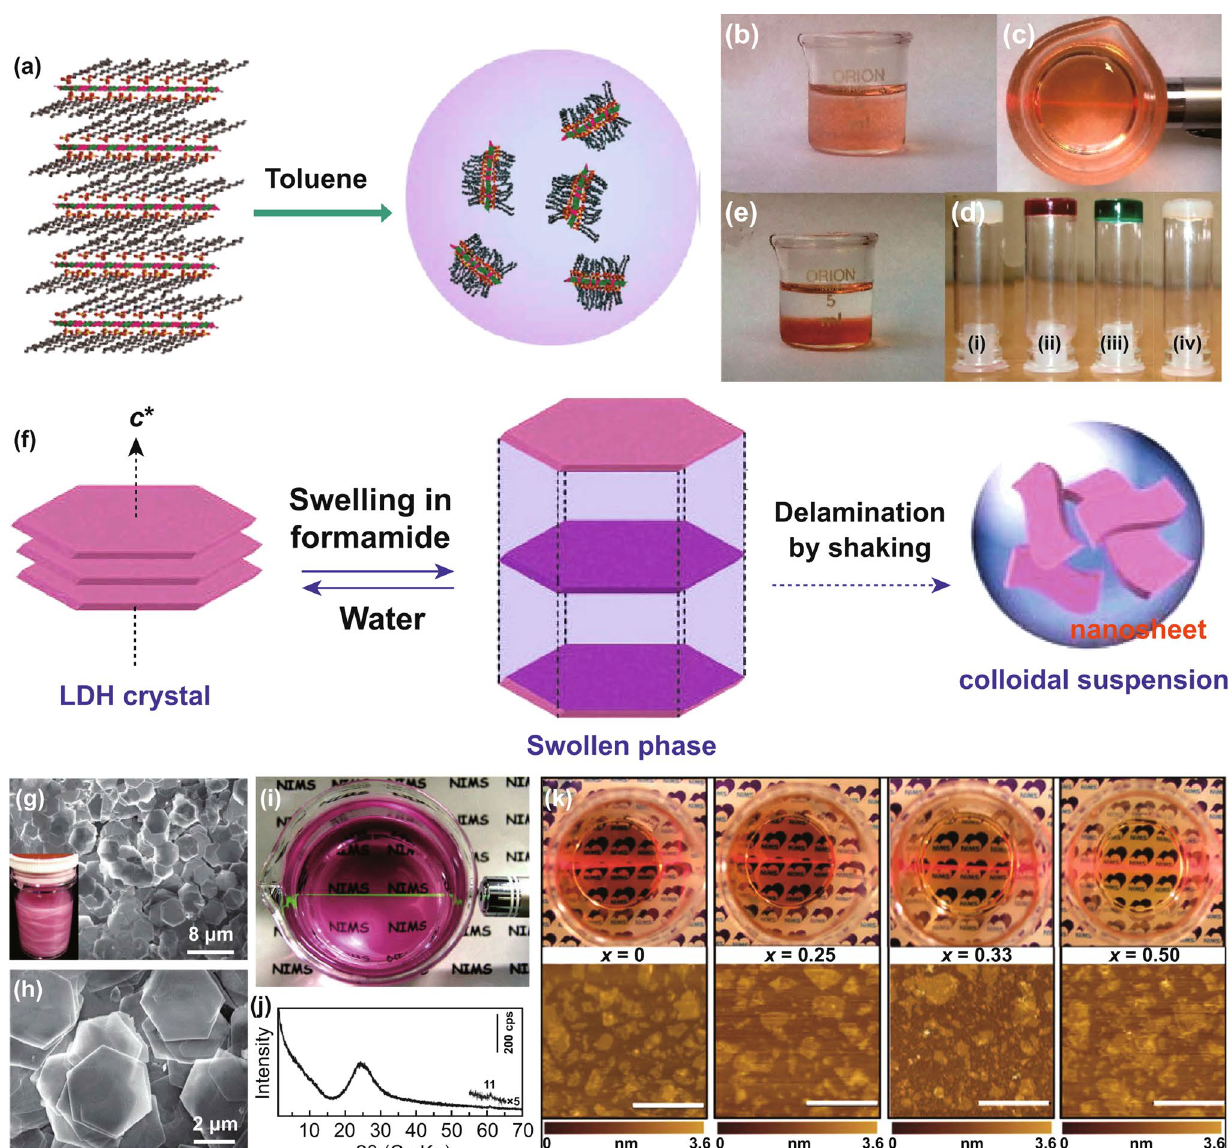
Fig. 5 a Delamination process of a surfactant‑intercalated LDH by toluene. b , c Photograph and Tyndall effect of Co–Al LDH dispersion exfoli‑ ated by toluene. d Test‑tube inversion test demonstrating the formation of toluene gels for dispersion of Mg–Al LDH (i), Co–Al LDH (ii), Ni–Al LDH (iii), and Zn–Al LDH (iv). e The Co–Al LDH dispersion exfoliated by toluene after 7 days. Reproduced with permission from Ref. [56]. Copyright 2011 American Chemical Society. f – j Delamination process, low‑ and high‑magnification SEM images, photograph and XRD pattern of the Co–Al–CO 3 LDH sample and the suspension. Reproduced with permission from Ref. [53]. Copyright 2006 American Chemical